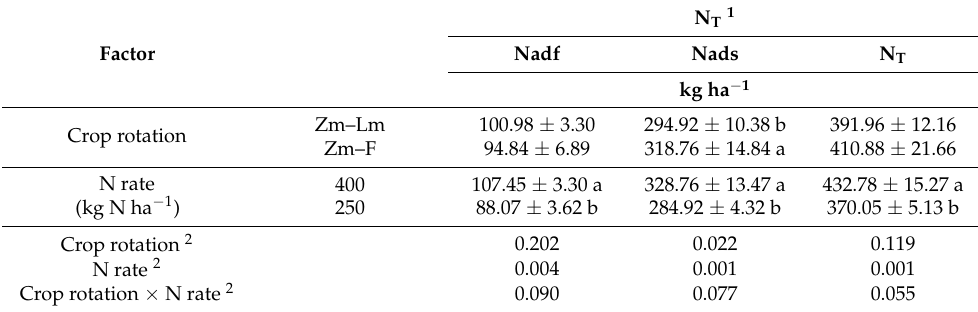
Table 6. Total nitrogen content (N T ) and uptake from both the fertilizer (Nadf) and the soil (Nads) in the maize